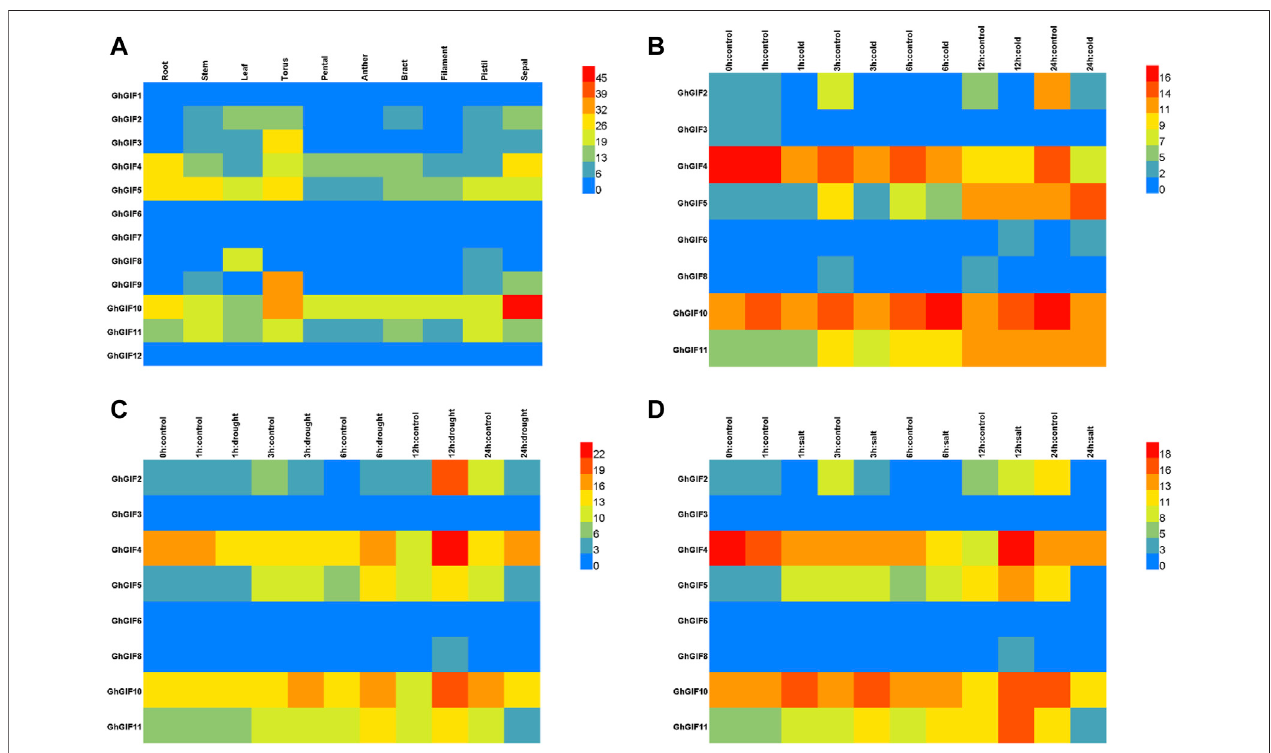
FIGURE4| TPMexpressionof GhGIF genesindifferentorganizationsanddifferentstresses. (A) TPMexpressionof GhGIF genesindifferentorganizationsinTM-1 (B) TPM expression of GhGIF genes under cold stress (C) TPM expression of GhGIF genesunder drought stress (D) TPM expression of GhGIF genes under salt stress.